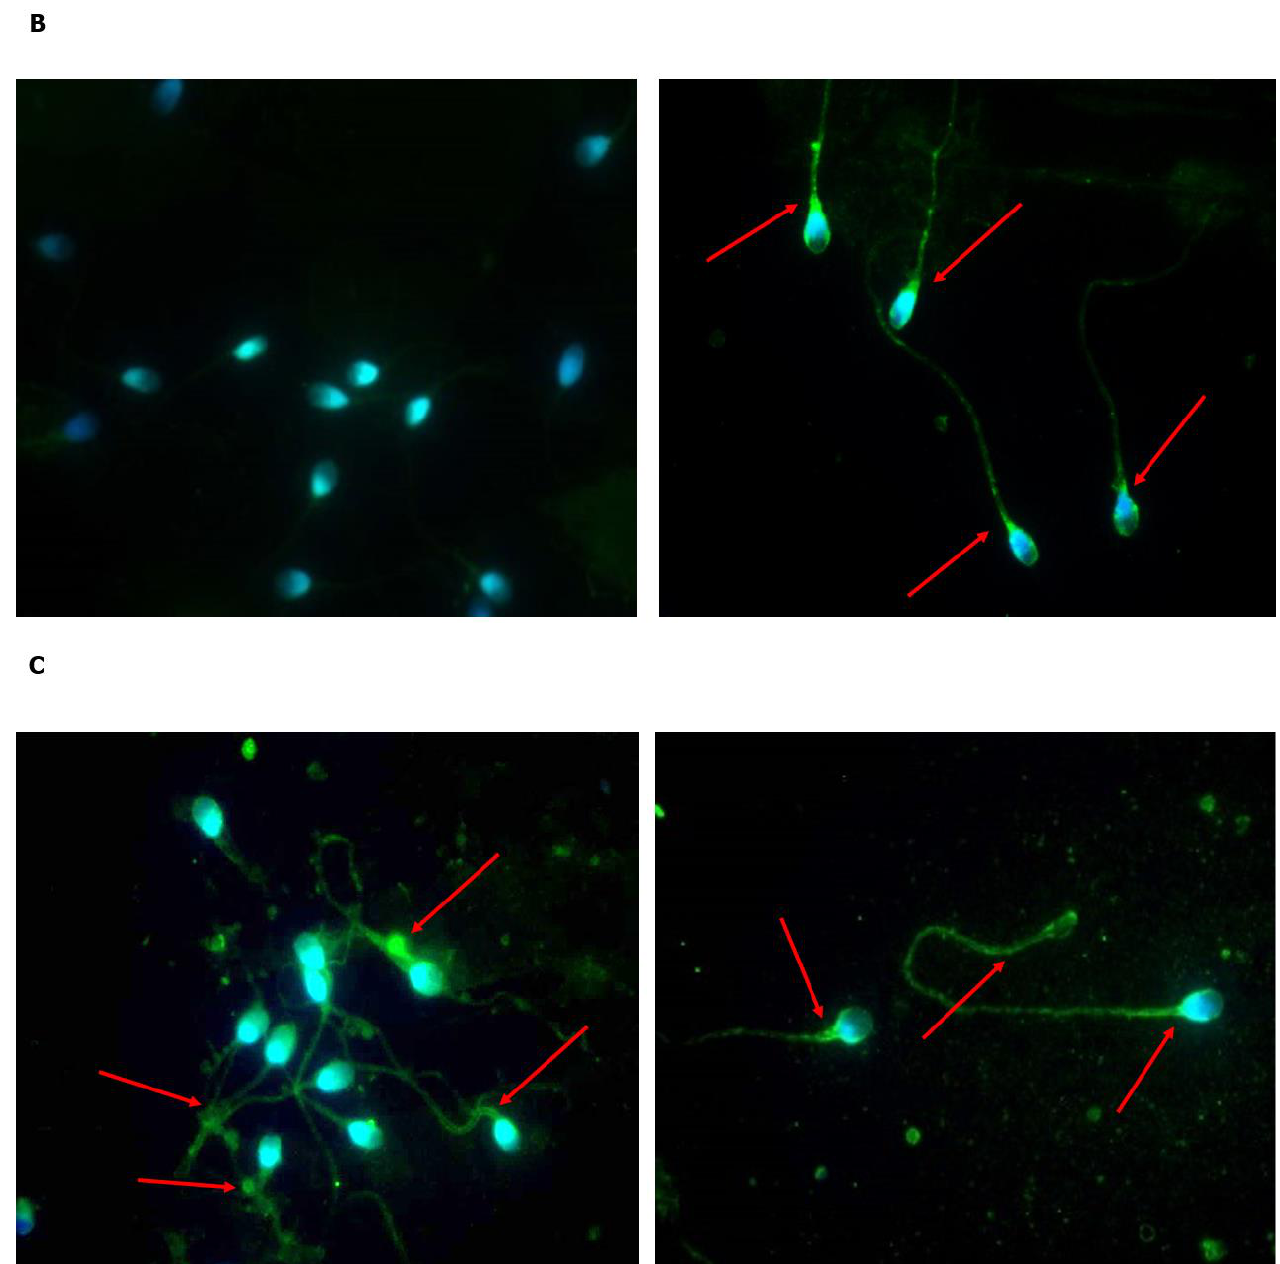
Figure 3. Immunolocalization of the follicle-stimulating hormone receptor (FSHR) protein in human spermatozoa after incubation with hpFSH. Immunofluorescence (IF) analysis of the FSHR in spermatozoa of controls and patients ( A ). Magnification from Patient 4: before incubation, the protein was not identified (Left panel). After incubation, it appeared in the post-acrosomal region, neck, midpiece, and tail (Right panel) ( B ). Magnification from Control 2 (Left panel) and Patient 2 (Right panel): the protein appears expressed even before incubation with FSH ( C ). Magnification 100×. IF is indicated by the red arrows in Panels B and C.